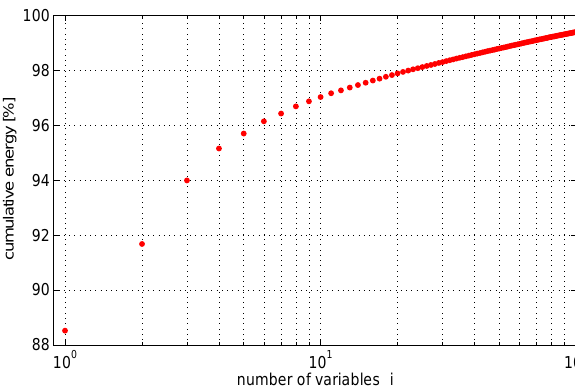
Fig. 3. Cumulative energy (in %) of the 100 dominant pairs of vari- ables, out of 657. The horizontal axis is logarithmic, revealing an inflexion around k = 4 − 6, which can be interpreted as the number of significant